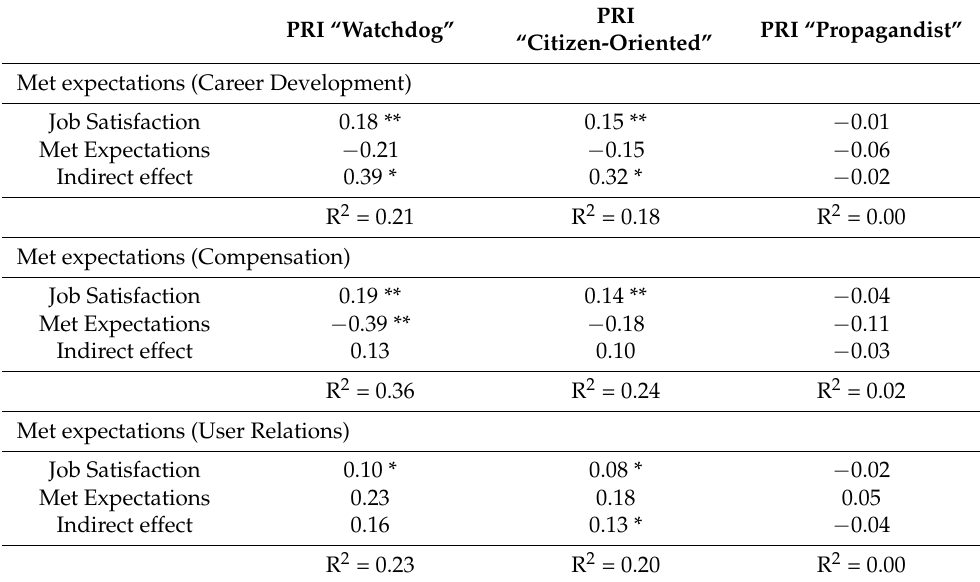
Table 2. Direct and Indirect effects of Met Expectations on Professional Role Identities. PRI PRI PRI “Watchdog” “Citizen-Oriented”